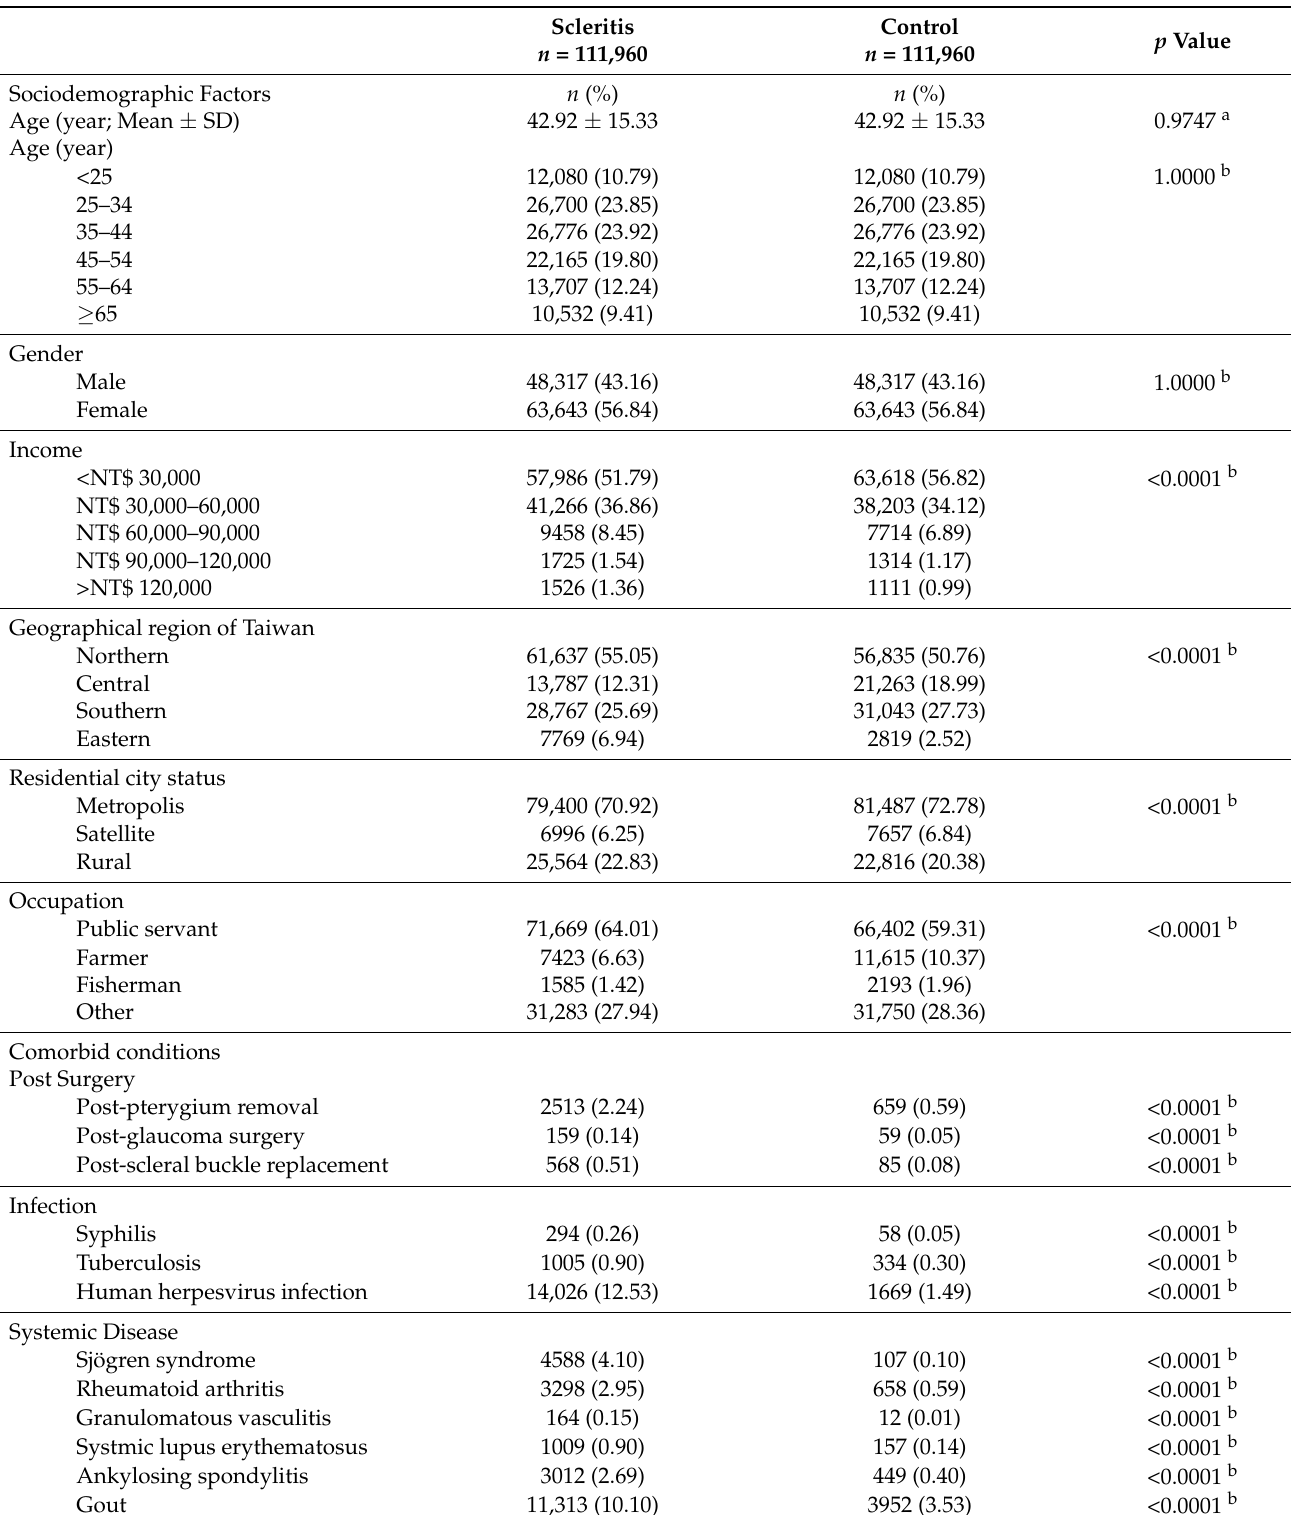
Table 1. Baseline sociodemographic factors and comorbid conditions of scleritis patients and control subjects after propensity score matching by age and